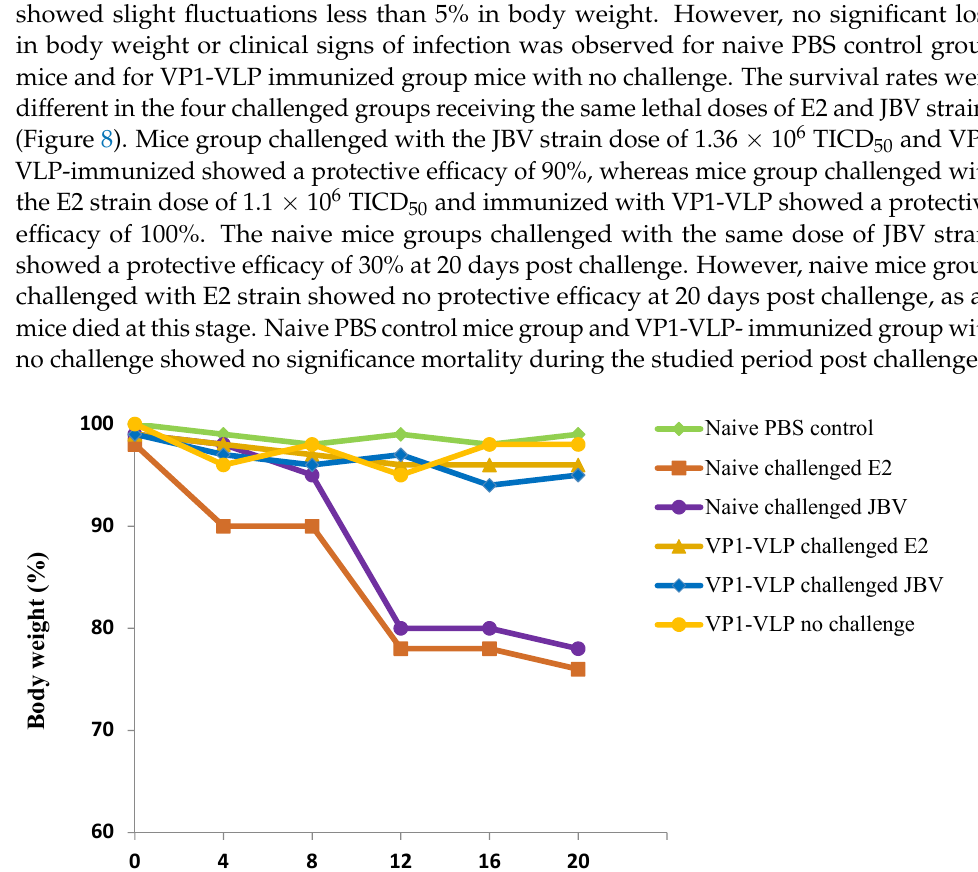
Figure 8. Survival percentage of all mice groups at di ff erent days after lethal challenge with patho- genic E2 and JBV strains. Mice groups not immunized and challenged by pathogenic strains showed the most elevated percentage of mortality. PBS naïve mice group represents the control group. 3.6. Pancreas Tissue Viral Titers Mice groups were sacri fi ced twenty days following lethal challenge with E2 or JBV strains and pancreas homogenates were prepared. HeLa epithelial cells were infected with pancreas samples and the viral titer was quanti fi ed by the tissue culture infectious doses in a given volume (TCID 50 ). Figure 9 shows the viral yield in all the vaccinated mice and naive control mice groups. The viral load was shown to be 10-fold lower in the VP1-VLP vaccinated and challenged mice groups compared to the naive challenged group and to